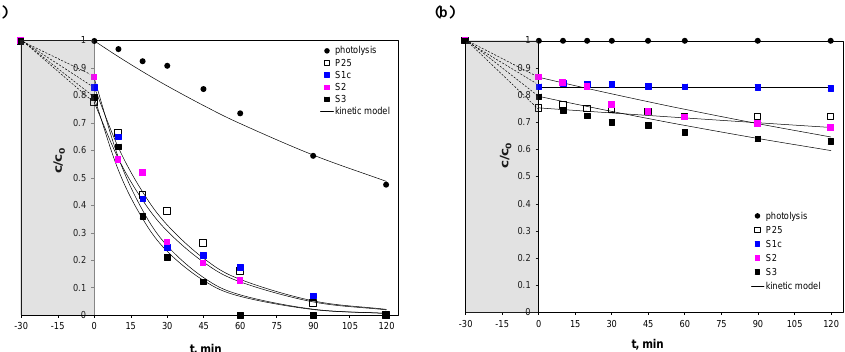
Figure 7. Kinetics and efficiency of photocatalytic degradation of salicylic acid (SA) under full-spectrum solar irradiation ( a ) and visible irradiation ( b ) using TiO 2 P25 and Ag@TiO 2 photocatalysts under given conditions. The grey areas represent the dark period prior reaction, i.e., time necessary to achieve sorption equilibrium.